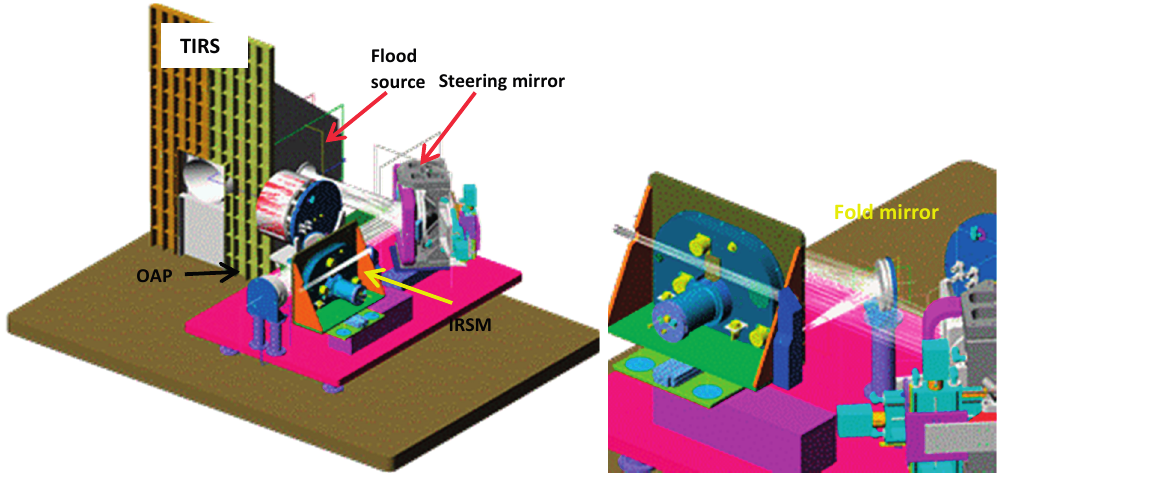
Figure 7. ( Left ) Drawing of the TIRS calibration equipment as placed in the chamber to illuminate TIRS. The various acronyms are defined in the text. In this drawing, which shows the light path for an external source, some of the coverings have been removed for clarity. ( Right ) Detail of the OAP optical system showing the field mirror that directs light from the IRSM to the